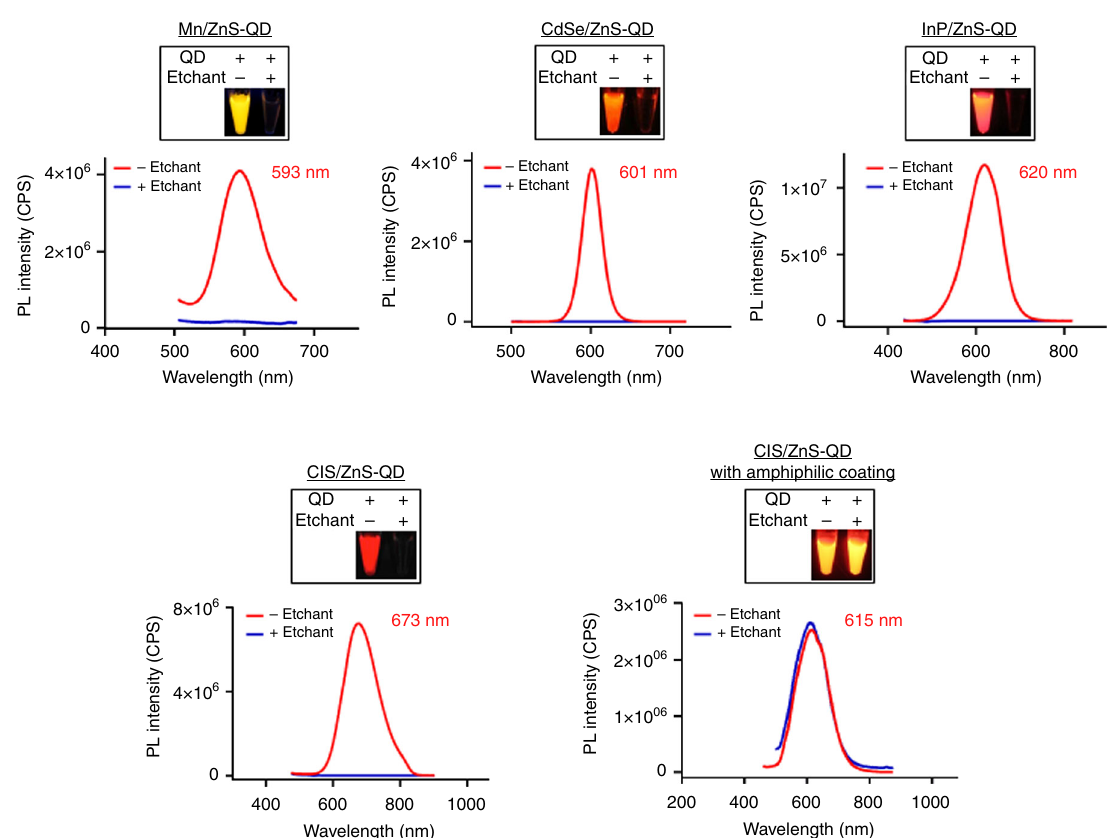
Fig. 2 In vitro etching of various QDs with Ag-TS. PL spectra of the QDs before (red) and after (blue) etching are shown. The emission peaks of the QDs are also listed. The boxed panels show fl uorescence images of the QD aqueous solutions with or without etching. QDs synthesized in-house (i.e., Mn/ZnS-QD) and high-quality commercial QDs (i.e., CdSe/ZnS-QD, InP/ZnS-QD, and CIS/ZnS-QD) were each etchable by Ag-TS. The Mn/ZnS-QD, InP/ZnS- and CIS/ZnS-QDs had coatings of 3-mercaptopropionic acid. Amphiphiliccoating with HS-(CH 2 ) 11 -(OCH 2 CH 2 ) 6 -NH 2 prevented CIS/ZnS-QD from being